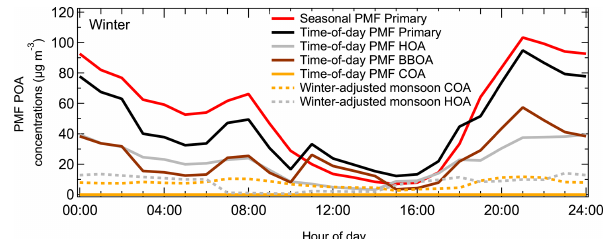
Figure 3. Diurnal patterns of seasonally representative hourly av- eraged primary PMF factors in winter 2017. Traffic and biomass burning contribute almost equally, whereas cooking has negligible